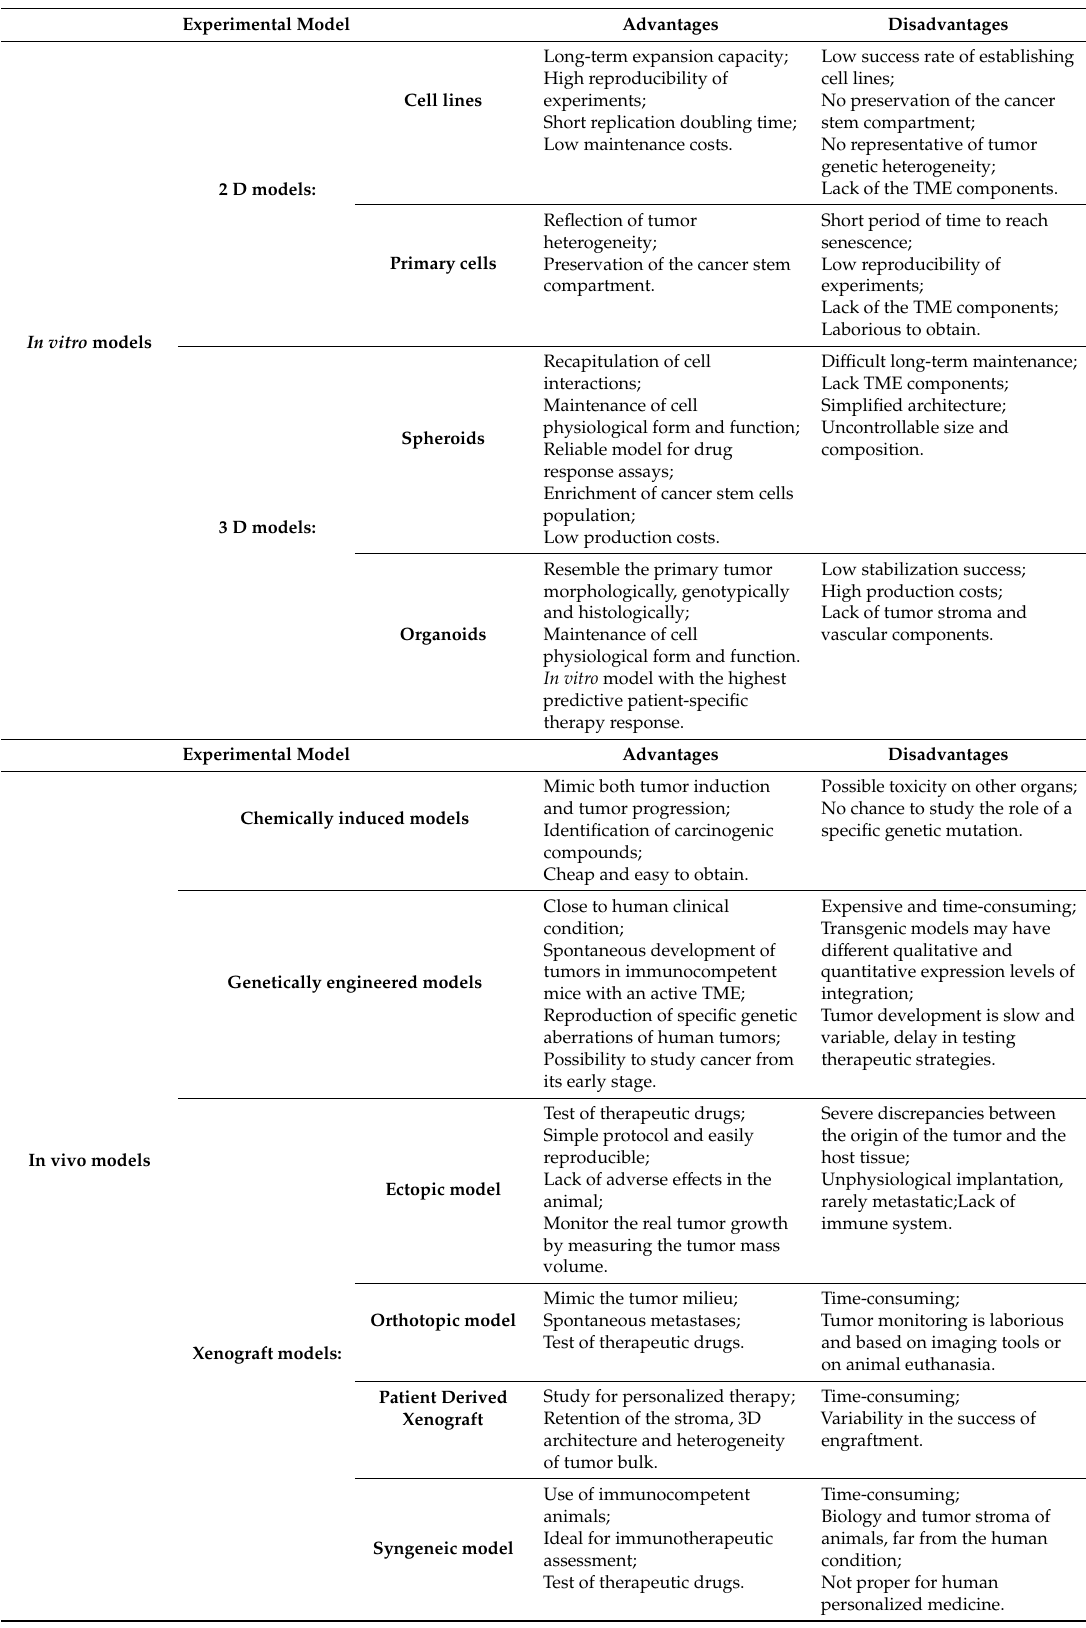
Table 5. Advantages and disadvantages of in vitro and in vivo CCA experimental